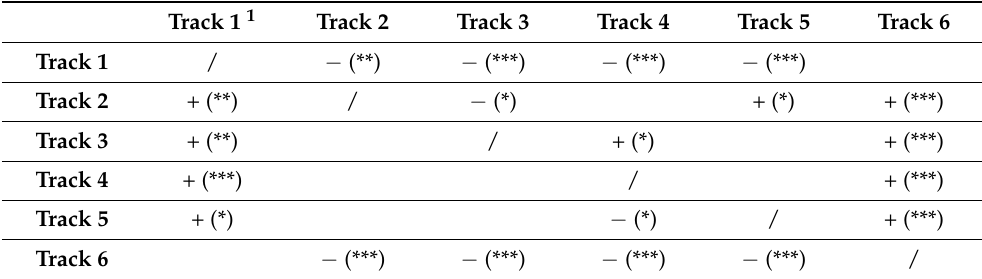
Table 9. The comparison of track numbers’ influence on paddle frequency between Q3 and